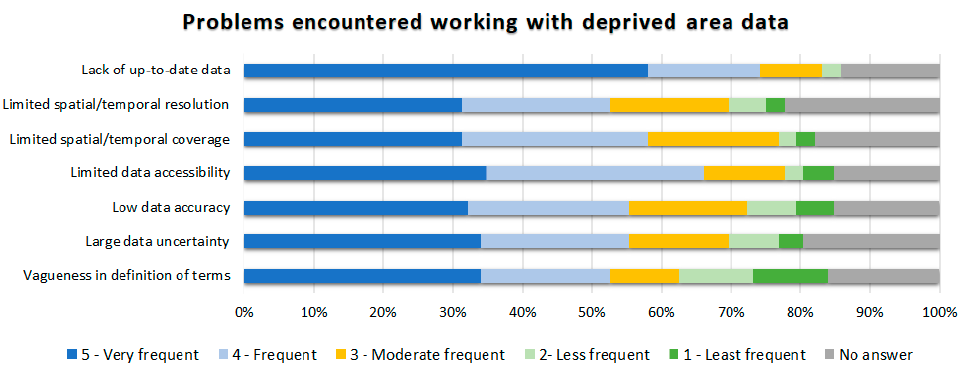
Figure 6. Results of the online expert survey, problems of deprived areas data encountered (N = 112).